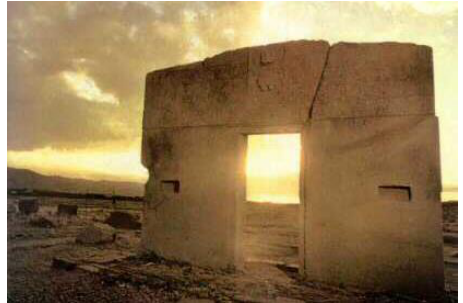
Fig. 6 Puerta del Sol, Teotihuacan, Bolivia